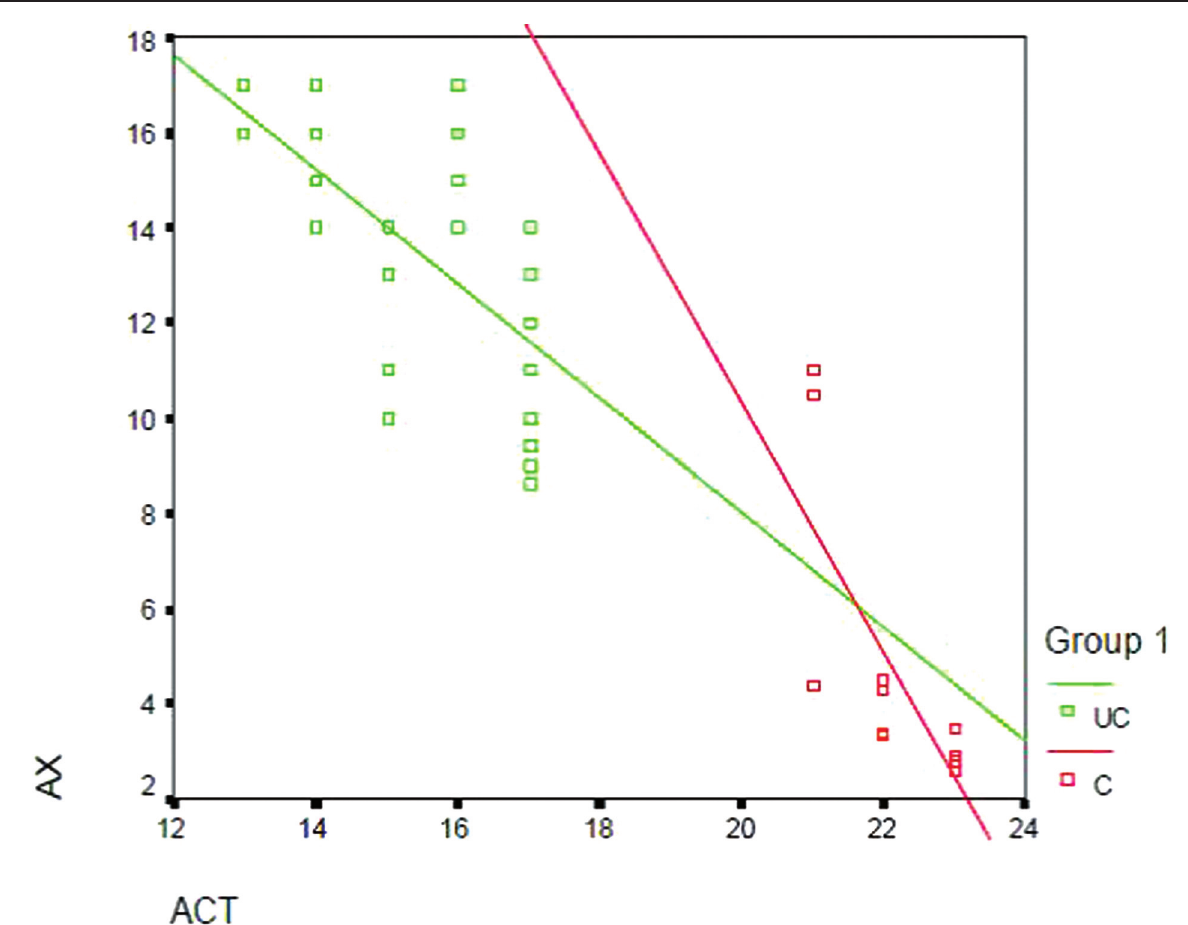
Correlation between AX and asthma control test in both groups.